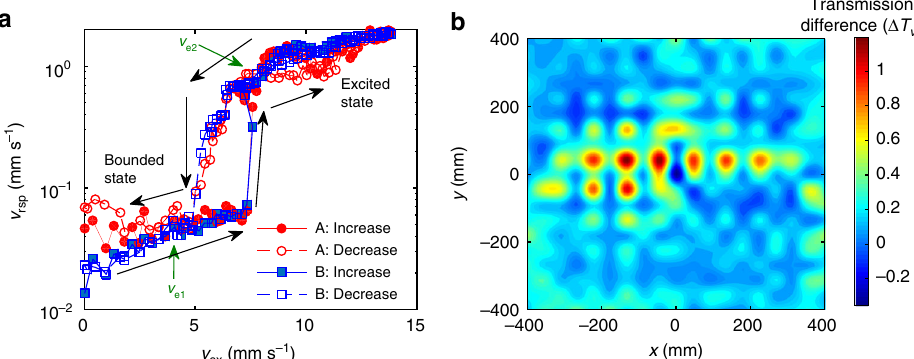
Fig. 7 Multi-states in the bandgap of NAM plate. Frequency is 760 Hz. a Response amplitudes v rsp at points A and B varying against the linearly and continuously varied driving amplitude v ex in time domain, i.e., the varying-amplitude experiment (see Methods). In the legend, Increase (decrease) refers to the process increasing (decreasing) v ex . Black arrows show the varying routes. b Contour plot of the transmission difference Δ T v between v e1 = 3.13 and v e2 = 8.55 labeled in a , Δ T v = T v − T v 2 1 . Scanning experiments were carried out to obtain this plot